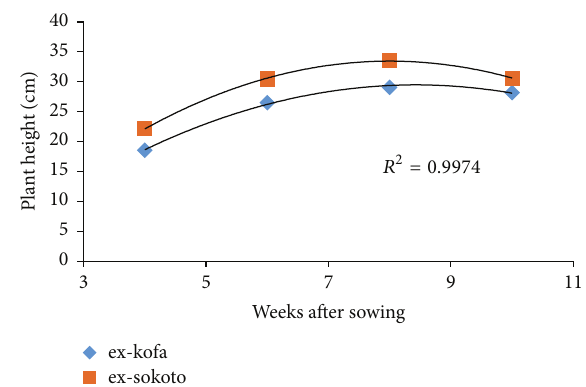
Figure 1: Significant ( 𝑝 < 0.05 ) growth trend of garlic varieties at 4, 6, 8, and 10 weeks after sowing on plant height. 𝑅 2 is the goodness of fit.